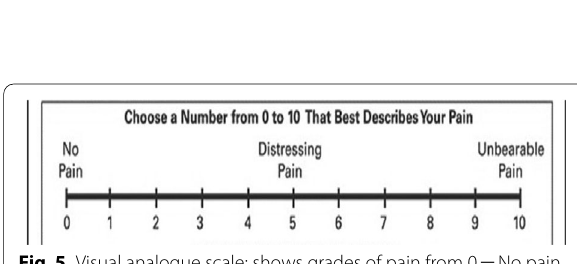
Fig. 5 Visual analogue scale: shows grades of pain from 0 to 10 unbearable =